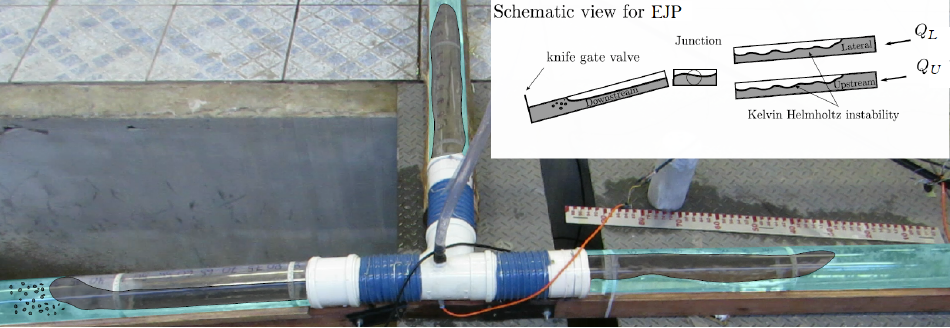
Figure 8. Visualization at some seconds after the knife gate closure showing the pressurization process for